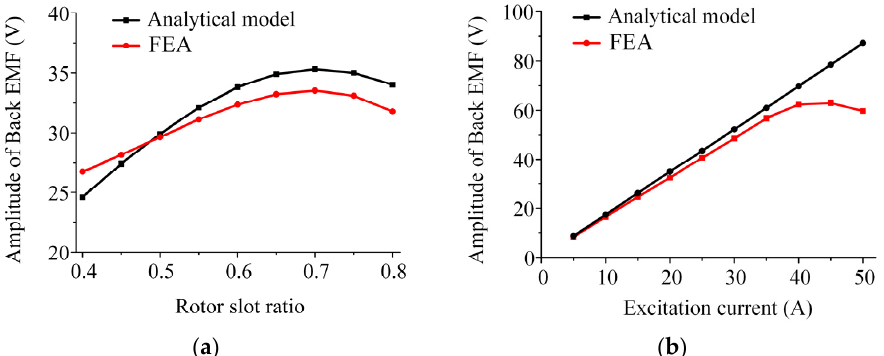
Figure 11. Comparison of FEA and analytical result of the back EMF: ( a ) rotor slot ratio; ( b ) excita- tion current.